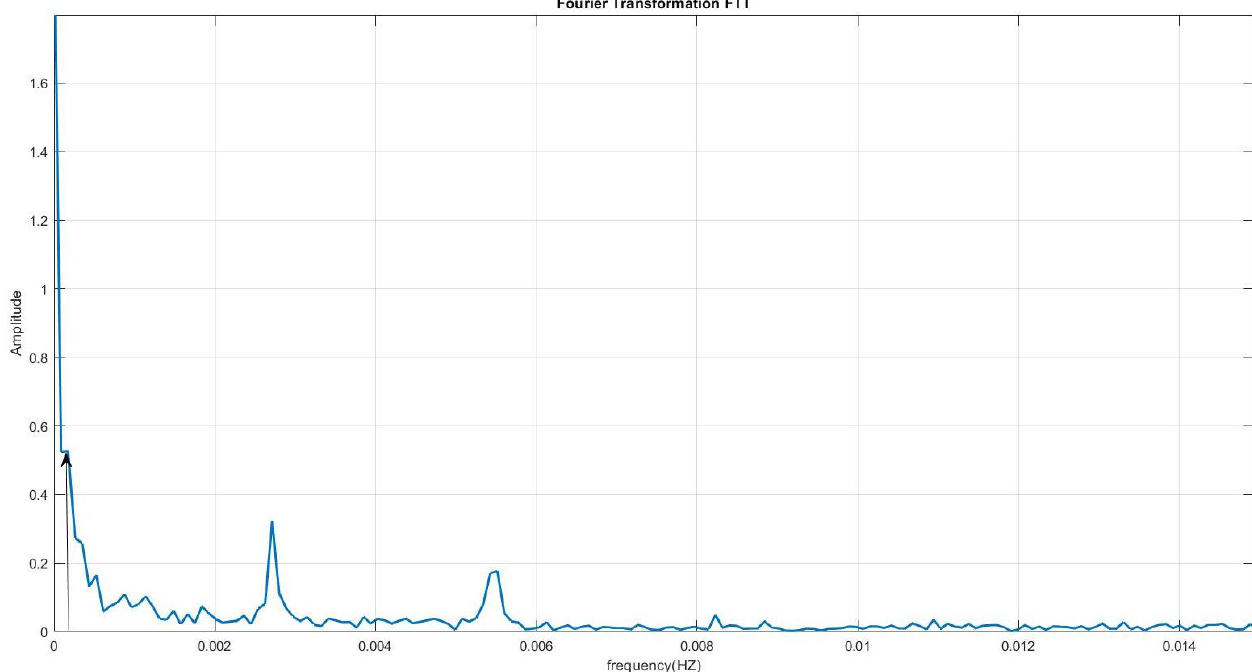
Figure 4. Spectral analysis of the LODR using fast Fourier transform